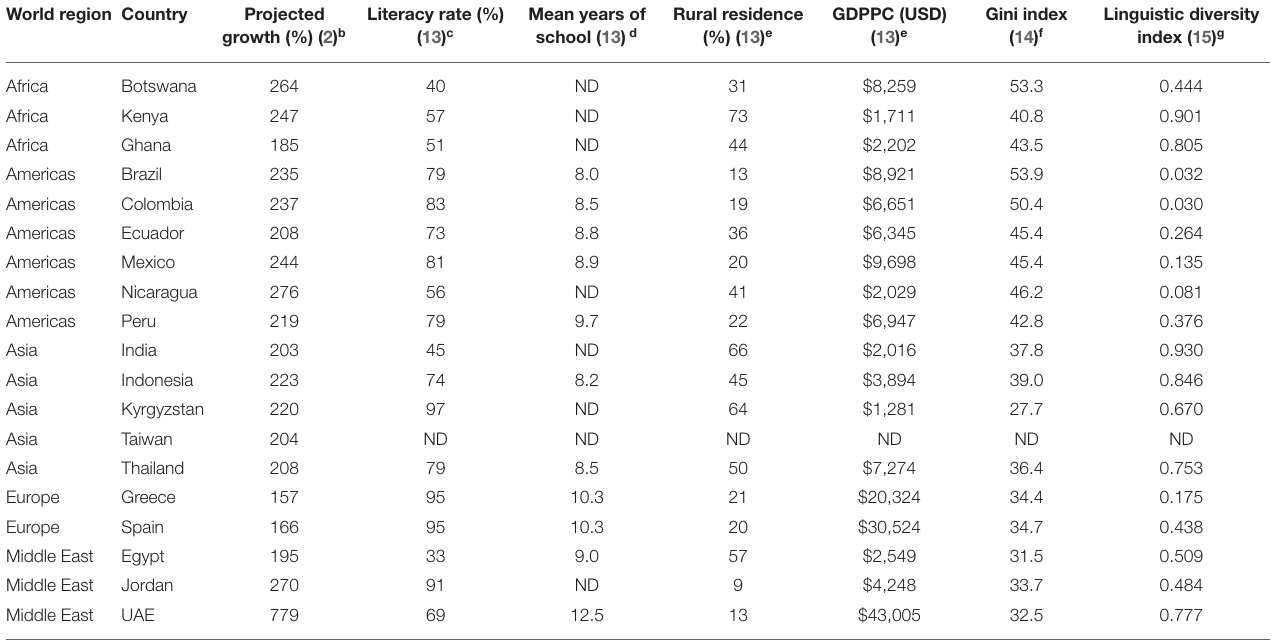
TABLE 1 | Characteristics of the 19 countries represented by experts in the study a . World region